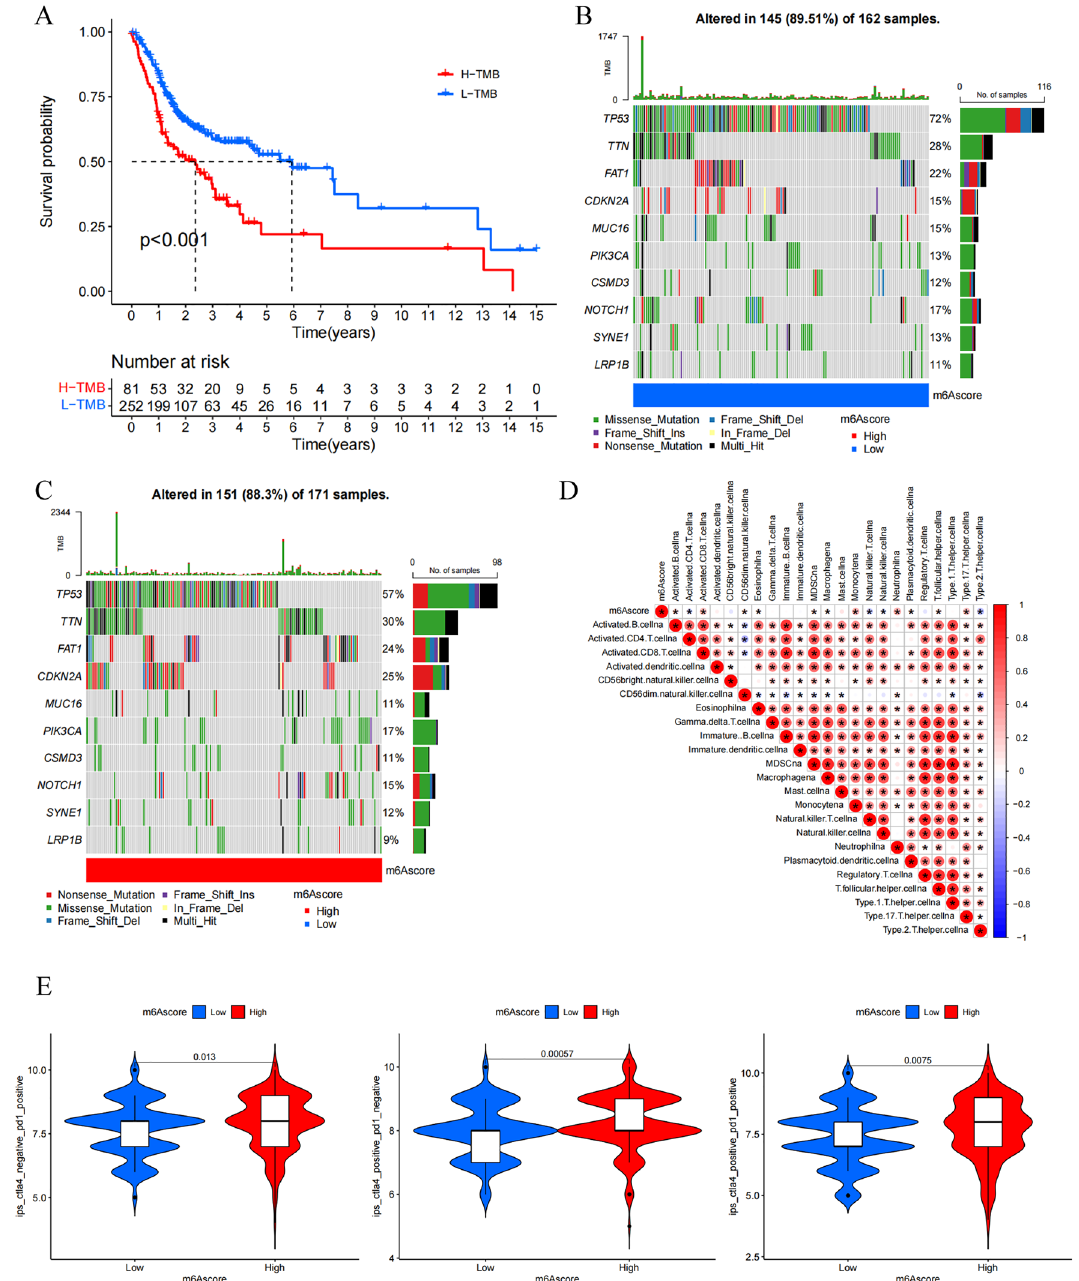
Figure 6. Mutation and immunity in tumor m 6 A modification patterns. ( A ) Kaplan–Meier survival analysis of OSCC patients in low TMB group and high TMB group. Low TMB group, blue curve; High TMB group, red curve. Log-rank p < 0.001 showed a significant survival difference between two groups. ( B,C ) TMB of top ten high-frequency mutated genes in 162 samples from low-m6Ascore group ( B ) and 171 samples from high- m6Ascore group ( C ). Each column represented a sample. The upper barplot showed TMB; the right barplot showed the proportion of each variant type. Numbers on the right represented the mutation frequency of genes. ( D ) Correlations between m 6 A score and immune cells infiltration using Spearman analysis. Negative correlation was marked with blue and positive correlation with red. *p < 0.05. ( E ) Correlations between m 6 A score and IPS. Low-m 6 A score group, blue; High-m 6 A score group, red. The upper number represented p value. p value less than 0.05 was statistically